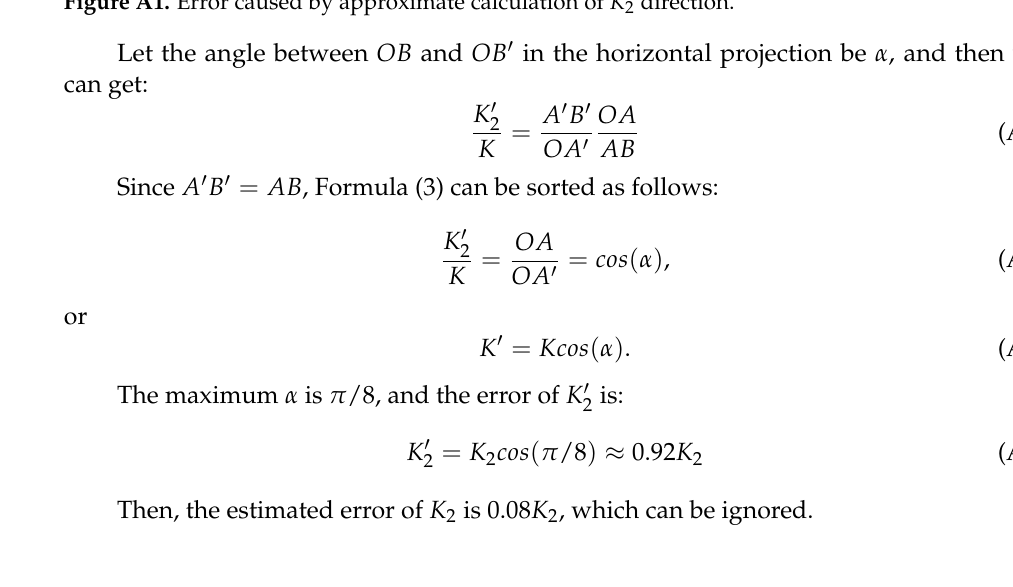
Figure A1. Error caused by approximate calculation of K 2